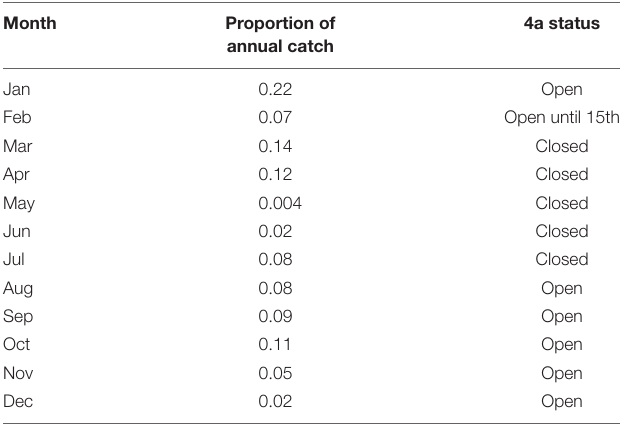
TABLE 1 | Mean proportion of total annual catch taken in each month and whether or not division 4a is closed to